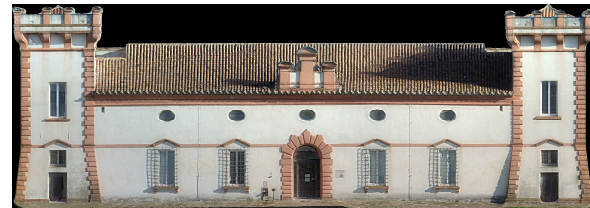
Figure 33: Ortophoto of the front façade of the castle.